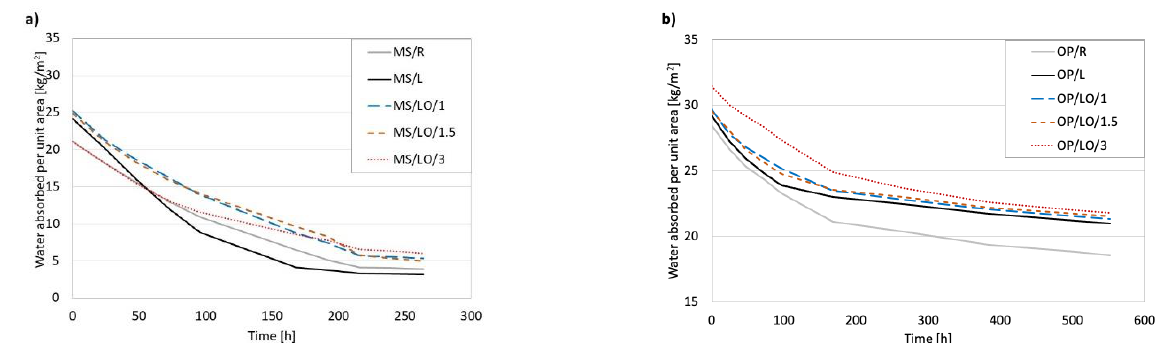
Figure 4. Drying curves with NaCl solution of ( a ) Mšené and ( b ) Opuka stone.